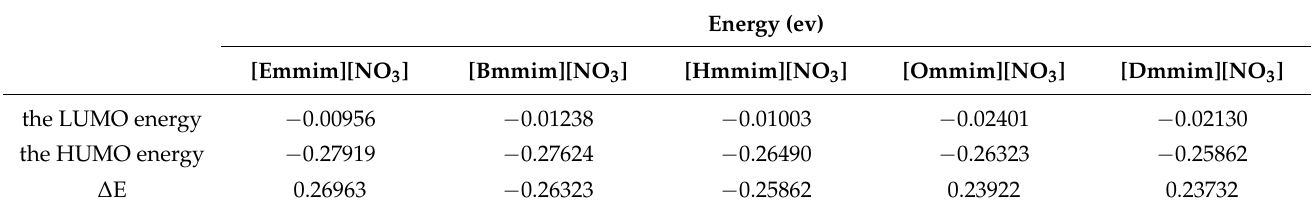
Table 7. The value results of the frontier molecular orbital. Energy